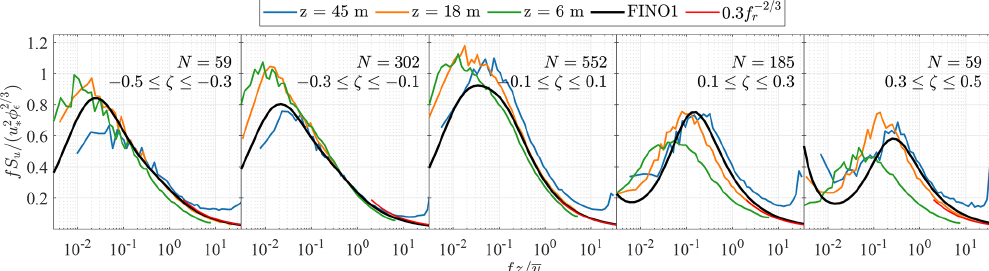
Figure 8. Normalised spectra of the along-wind component at 45, 18, and 6ma.m.s.l. for various stability conditions. The red curve is derived from Eq. (5), and N denotes the number of samples considered for ensemble averaging.